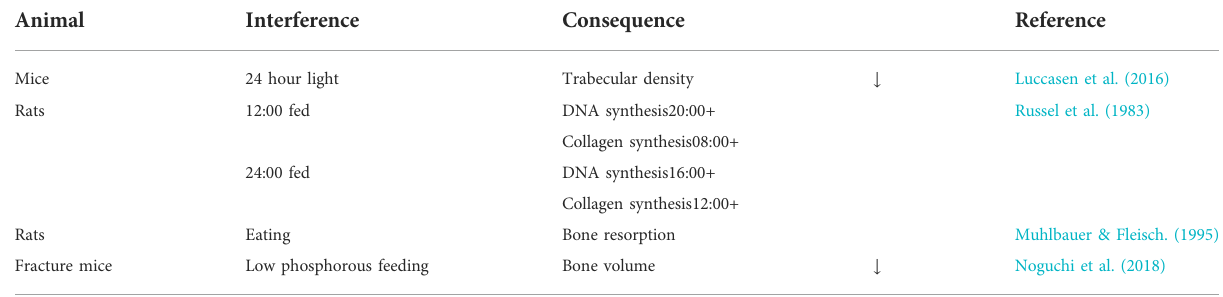
TABLE 5 Biological rhythm disorders in bone tissue lead to osteoporosis in animal studies.